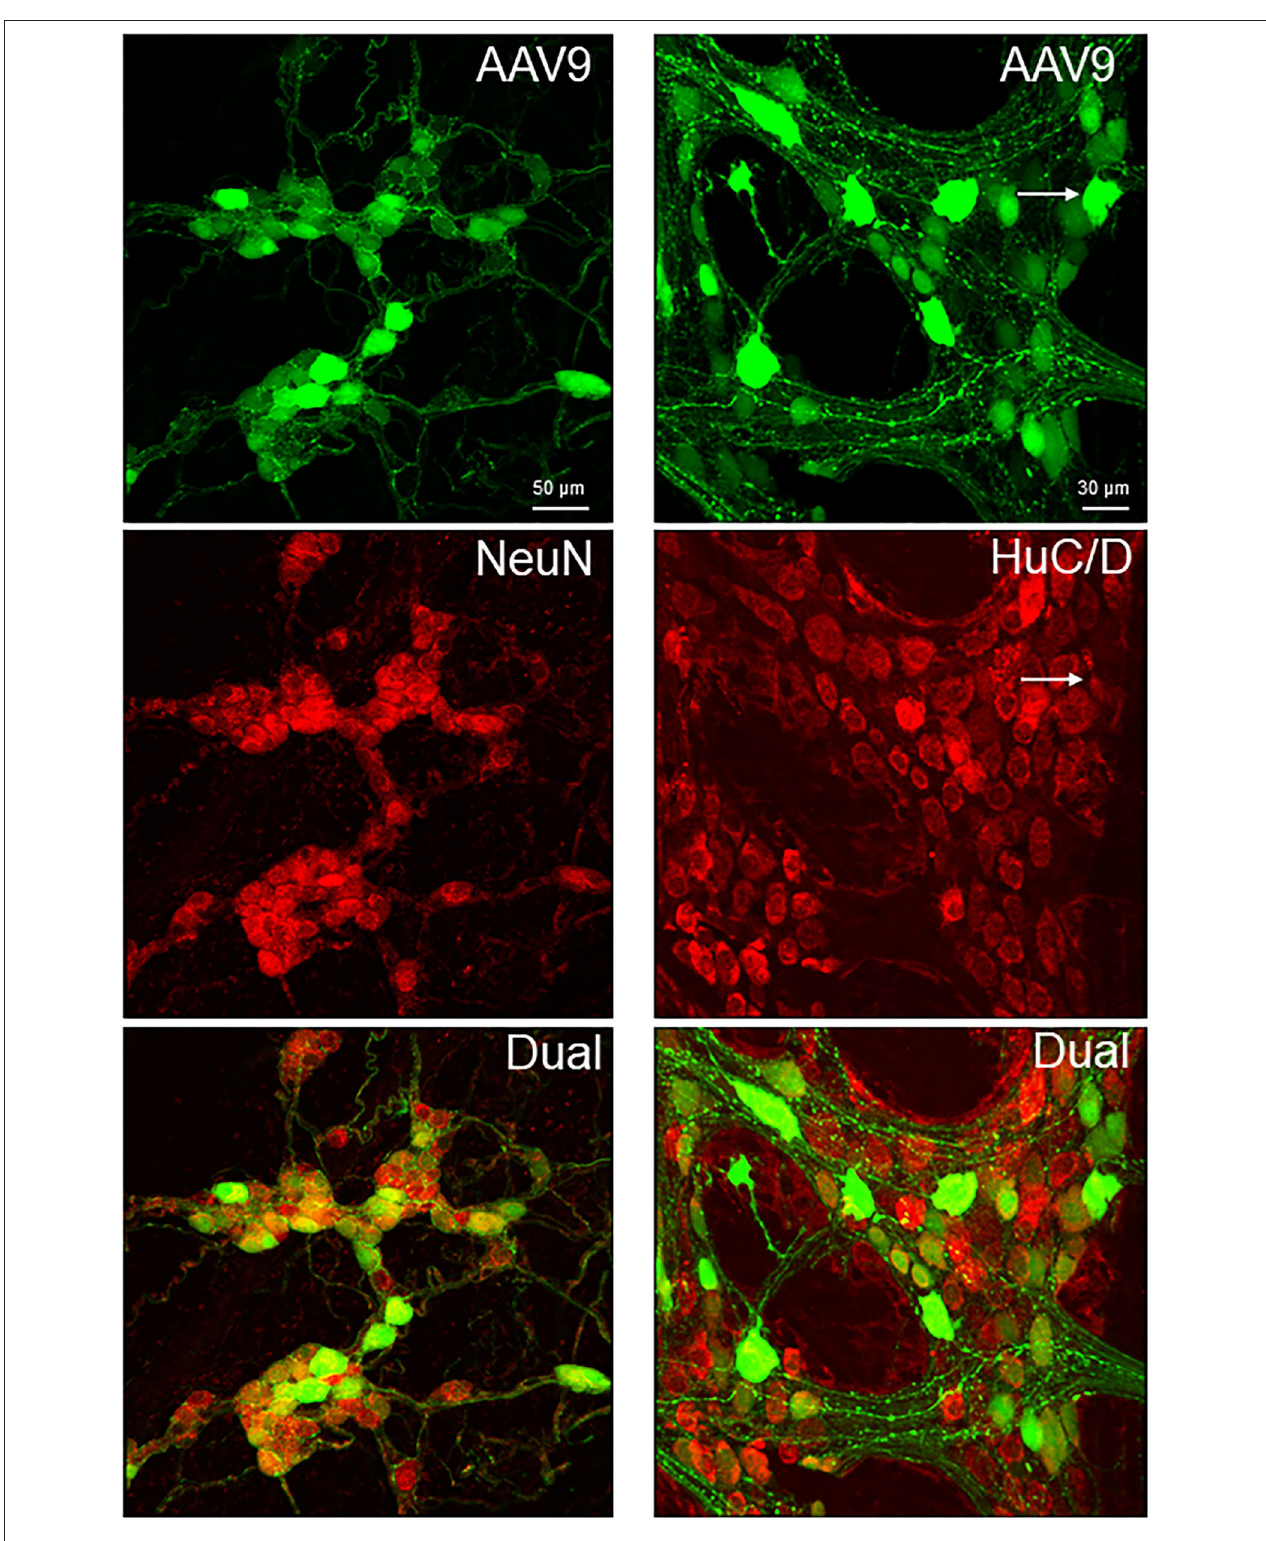
FIGURE 4 | Dual labeling of AAV9 transduction and immunofluorescence of pan-neuronal markers, NeuN in the submucosal plexus (left panels) and HuC/D myenteric plexus (right panels) in whole mount preparations of the mouse proximal colon. AAV9-CAG-GFP was retro-orbitally injected at 3.3 x 10 11 GC/mouse 3 weeks before. The submucosal neurons were labeled by NeuN, due to a lot of non-specific labeling by the HuC/D antibody.